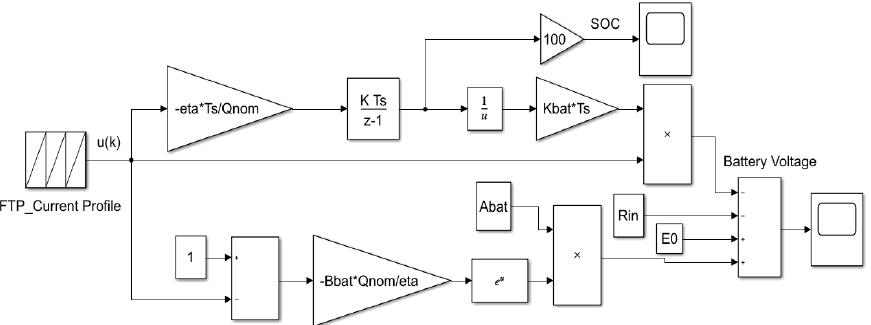
Figure 20. Simulink Simscape Diagram of Li-ion model. The values of the parameters from Simulink diagram are allocated in a MATLAB script that runs first for initialization, and then is running the Simulink model to extract these values from MATLAB workspace.